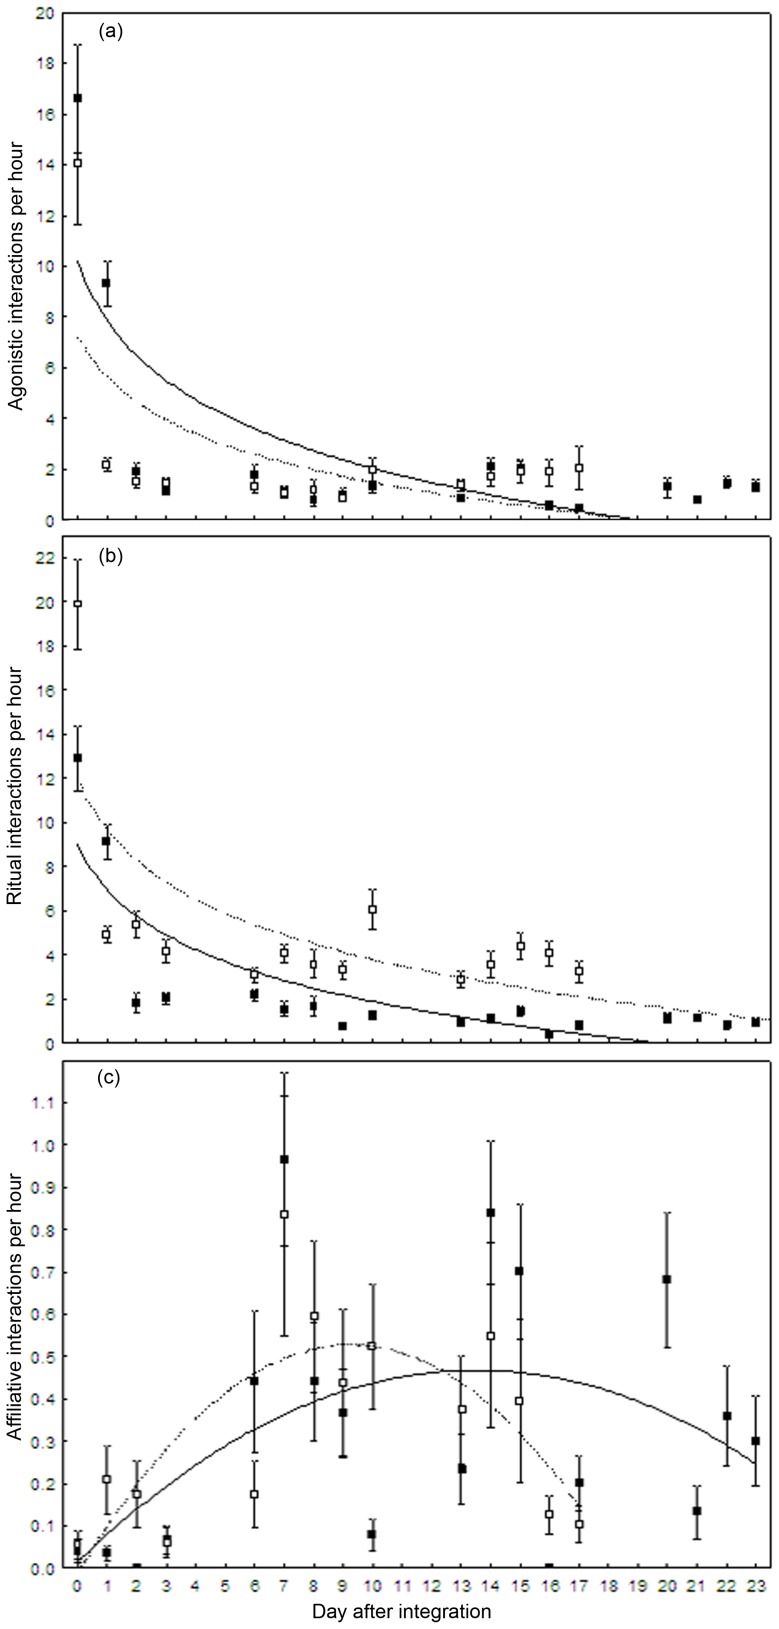
Changes with time in the frequency of social interactions after group integration.Frequency of interactions per hour (mean±SE per day; agonistic (a), ritual (b) and affiliative (b) interactions) as a function of time (days) in 2009 (black square) and in 2010 (empty squares). The best fit (log or quadratic) is indicated with a solid line for 2009 and dashed line for 2010 data.